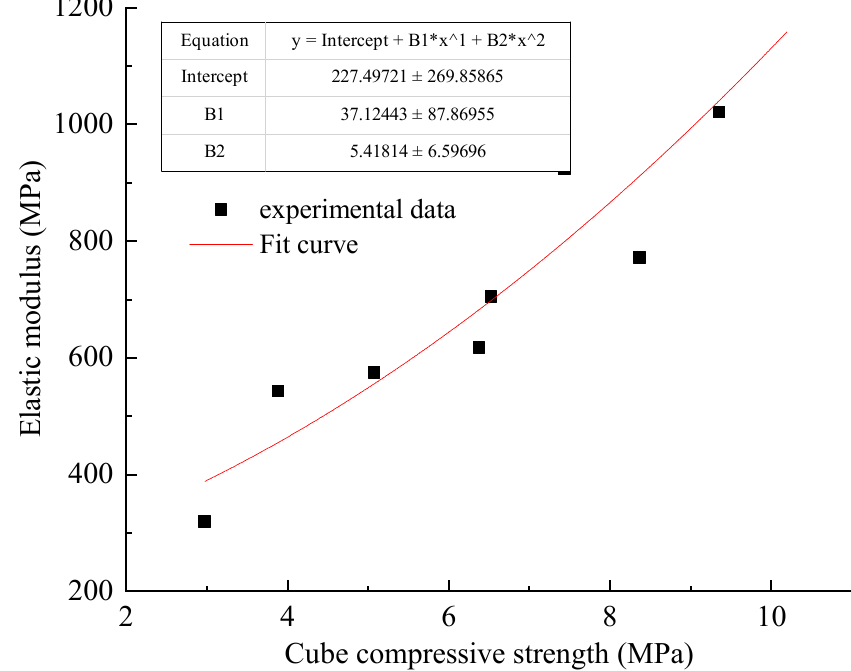
Figure 7. Relationship between cube compressive strength and elastic modulus. The square sum of residual error of fitting Formula (3) is 25,707.028, and the value is too large. It can be seen that the fitting is not convergent, and the error is large, but the goodness of fit R 2 = 0.966. Combined with Figure 4, it can be seen that the